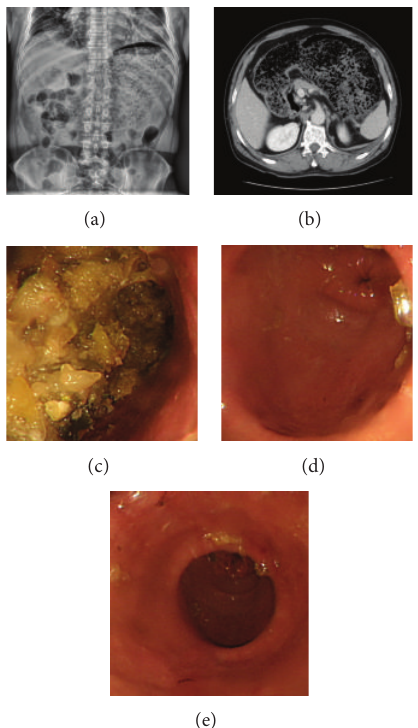
Figure 1: (a) Simple abdominal X-ray reveals a large amount of material in the stomach, suggesting severe gastric hypomotility. (b) Abdominopelvic computed tomography reveals a large amount of food material in the stomach, suggesting partial stricture in the postbulbar portion of the duodenum. (c) Endoscopic findings reveal large amounts of food stored in the gastric body and antrum. (d) The food was removed using a cap-fitted endoscope and a net over a period of days. (e) Peristaltic motion of the gastric antrum was normal and the pylorus opened and closed